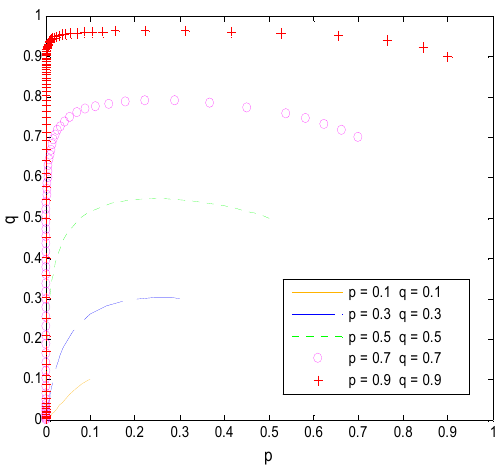
Figure 6. The evolution process of Case 1.